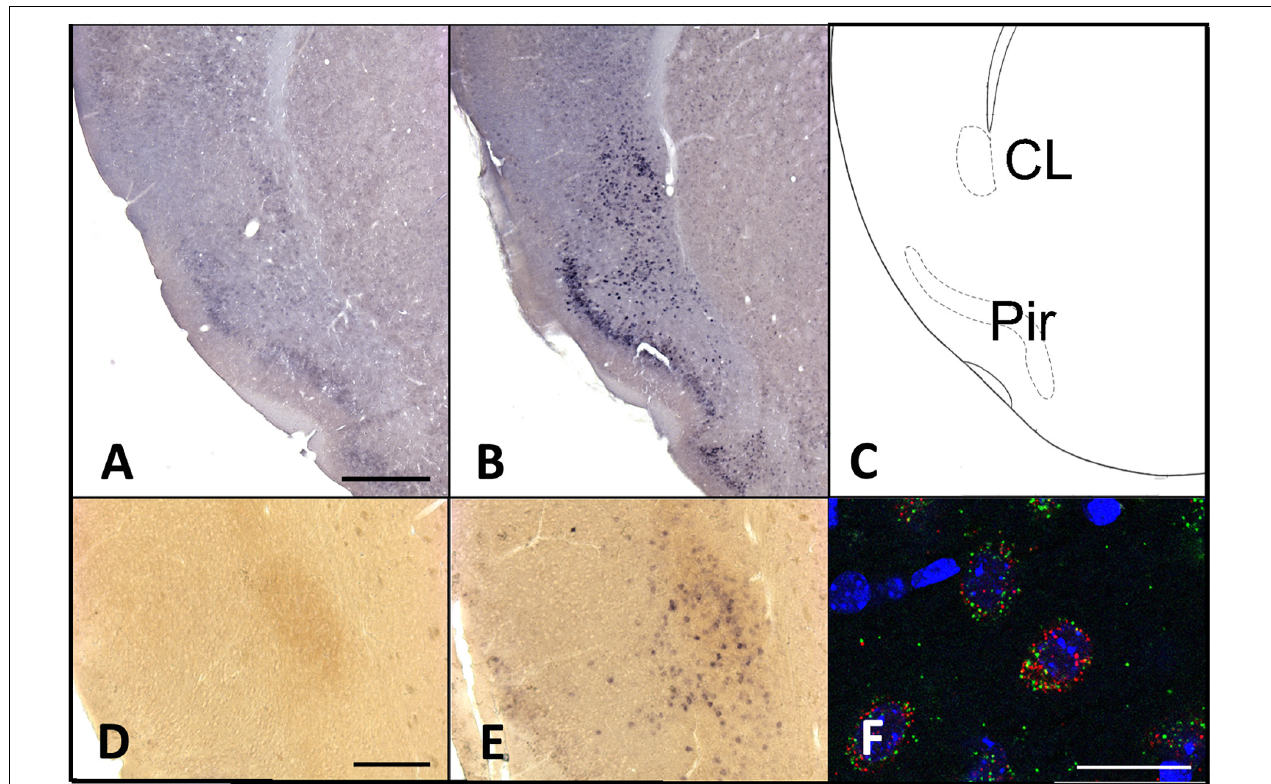
FIGURE 2 | Increases in homer1a mRNA are localized to the claustrum and piriform cortex. (A) Homer1a in situ 3 h sleep control (SC); (B) Homer1a in situ hybridization 3 h sleep deprivation (SD); (C) corresponding zoomed-in atlas image; (D) Homer1a in situ and GNG2 immunostain in 3 h sleep control; (E) Homer1a in situ and GNG2 immunostain in 3 h SD; (F) Homer1a (red), and Gng2 (green) RNAscope with DAPI (blue). Bar size A: 500 µ m, D: 250 µ m, F: 25 µ